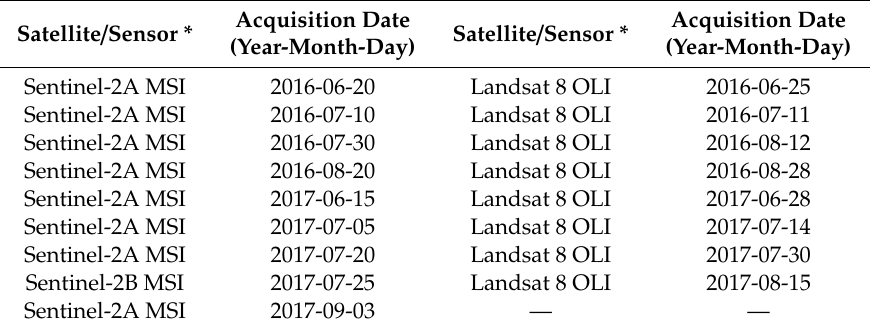
Table 1. Satellite imagery used in this